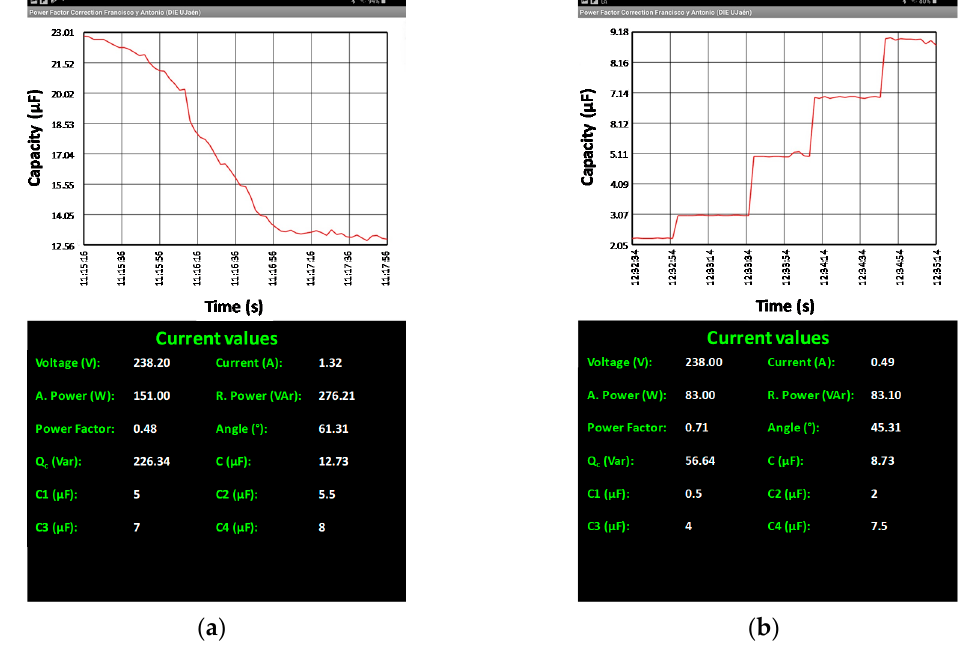
Figure 24. Permanent regime: ( a ) Lamps metal halide; ( b ) Resistance and Inductance Parallel.